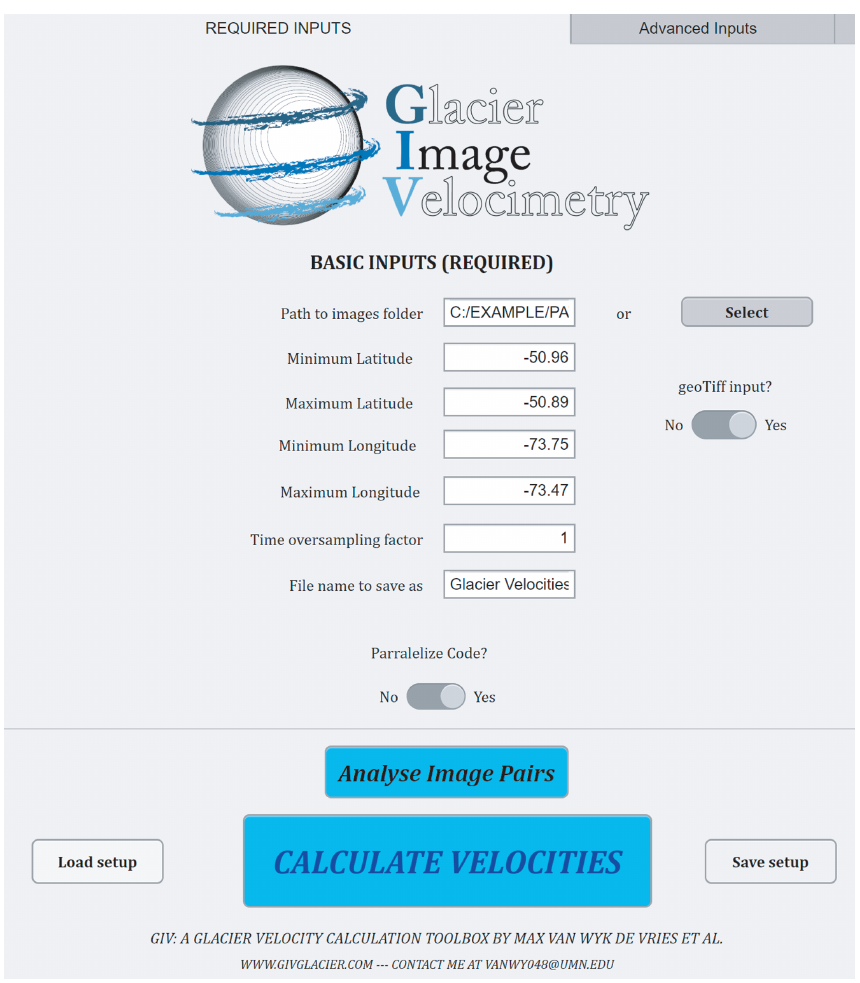
Figure 11. Main graphical user interface for GIV showing the main input fields. This interface may either be run through MATLAB or as an independent desktop app with no licensing